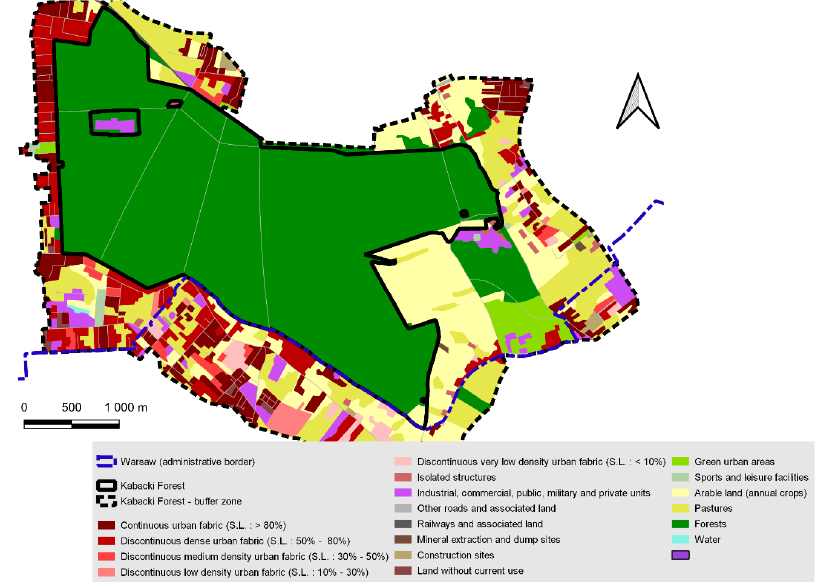
Figure 8. Land cover of Kabacki Forest, based on 2018 Urban Atlas data. As the name of site sug